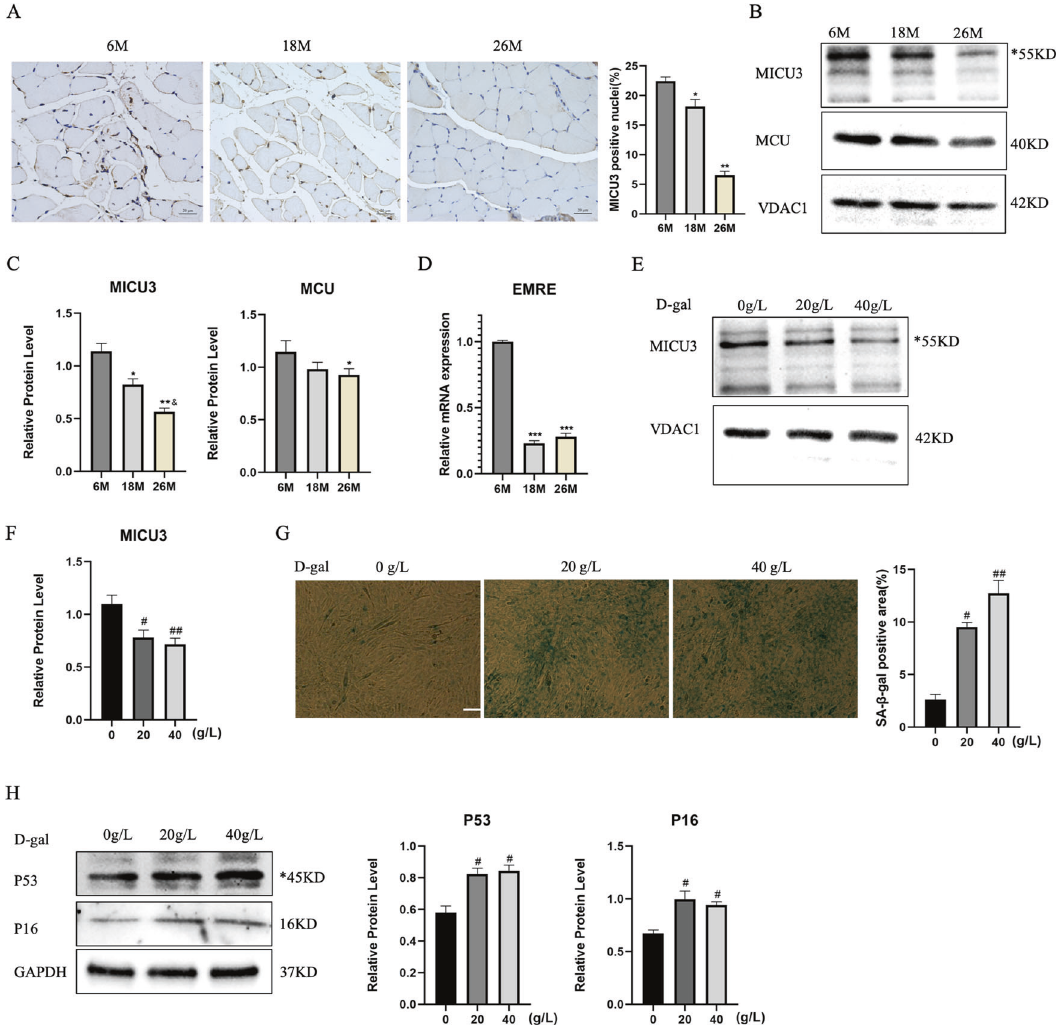
Fig. 1 MICU3 was downregulated in skeletal muscle from old mice and senescent C2C12 cells induced by D -gal. A IHC for MICU3 in mice gastrocnemius muscle (magni fi cation ×400; scale bar = 20 μ m). B , C Western blot and quanti fi cation of MICU3 and MCU protein level in mice gastrocnemius muscle. VDAC was used as the loading control. *indicates target bands. D The mRNA level of EMRE in mice gastrocnemius muscle. E , F Western blot and quanti fi cation for MICU3 in C2C12 cells. VDAC was used as the loading control. *indicates target bands. G SA- β - gal staining and quanti fi cation for C2C12 cells (scale bar = 50 μ m). H Western blot and quanti fi cation for P16 and P53 in C2C12 cells. *indicates target bands. GAPDH was used as the loading control. Data were expressed as mean ± SEM, and data were analyzed using a one-way